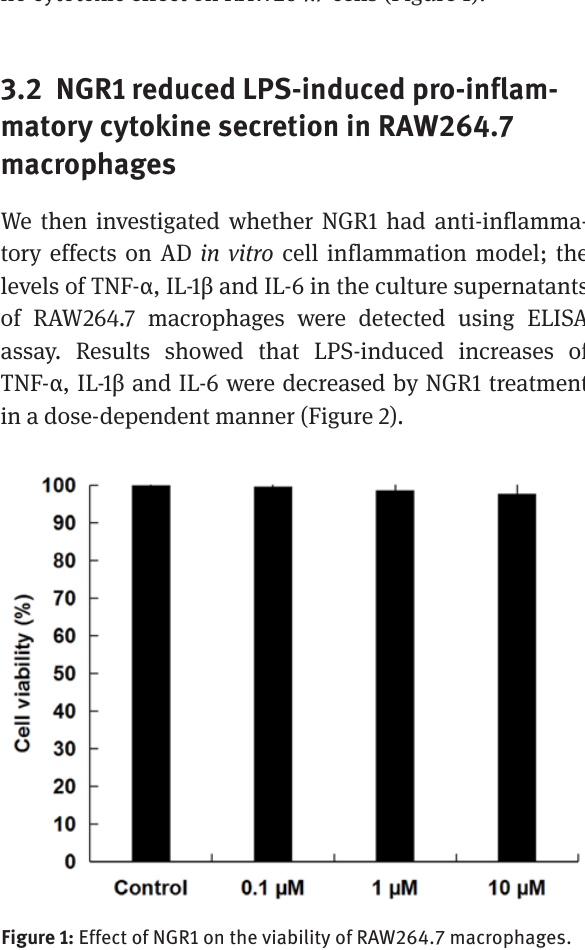
Figure 1: Effect of NGR1 on the viability of RAW264.7 macrophages. RAW264.7 cells were treated with concentrations of NGR1 (0.1, 1, and 10 µ M) for 24 h, the cell viability was then determined by MTT assay. Data were displayed as the mean ± SD.